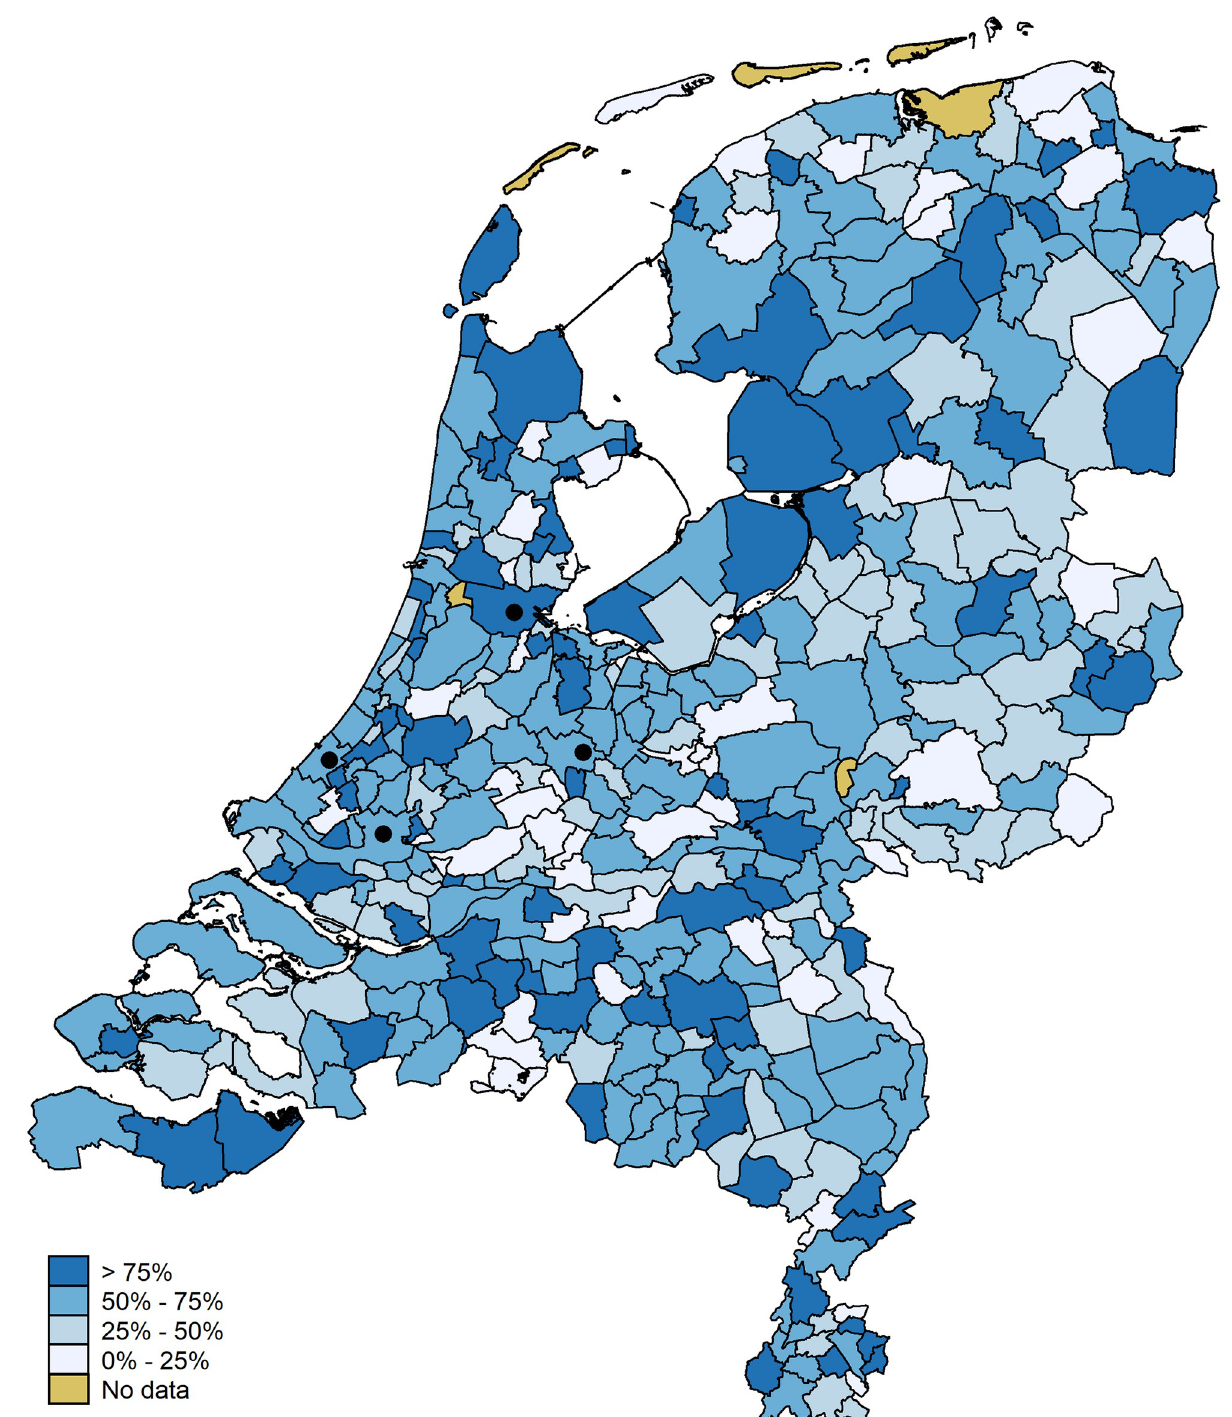
Fig 7. Location accuracy per municipality. Digital geometry (i.e., the shapefile) obtained from CBS/Kadaster [30]).